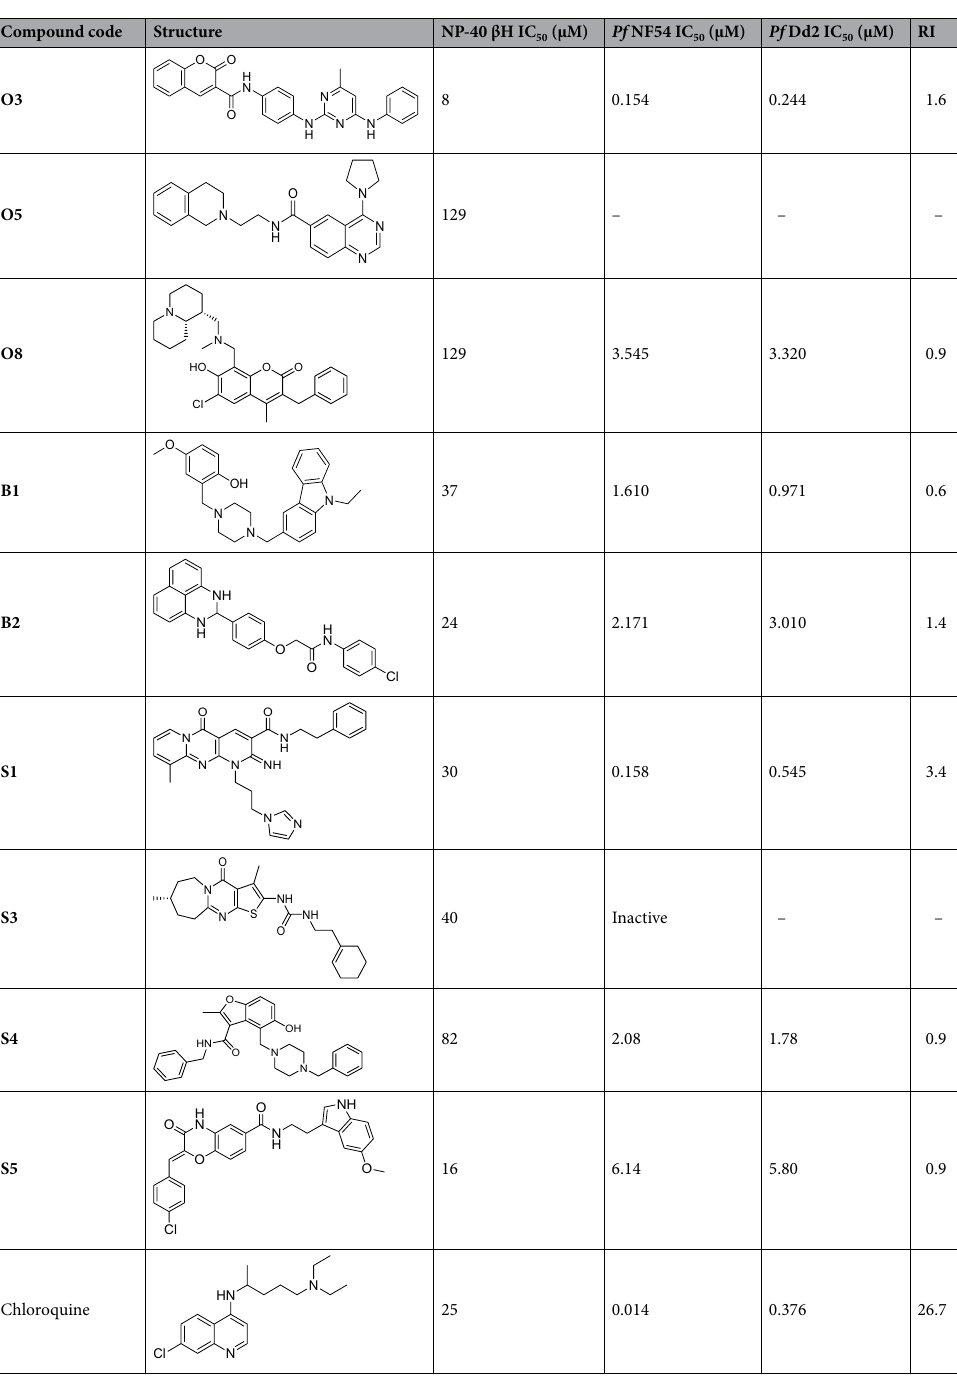
Table 2. Experimentally active βH inhibitors purchased from ChemDiv, prioritised by molecular docking and machine learning